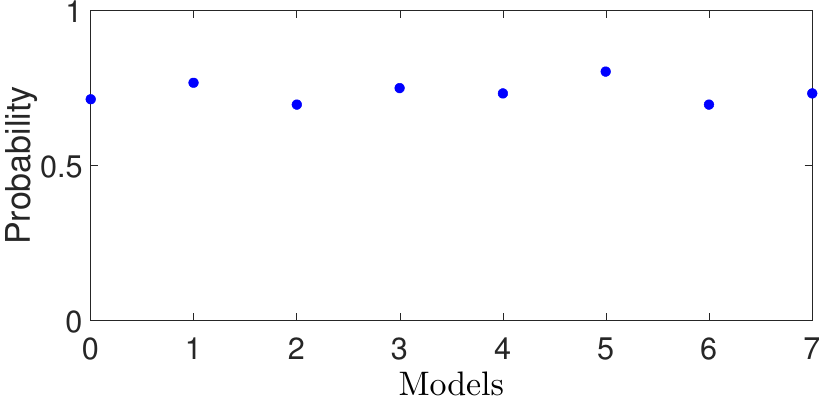
Figure 19. Probability of closed-loop stability vs. weight matrix